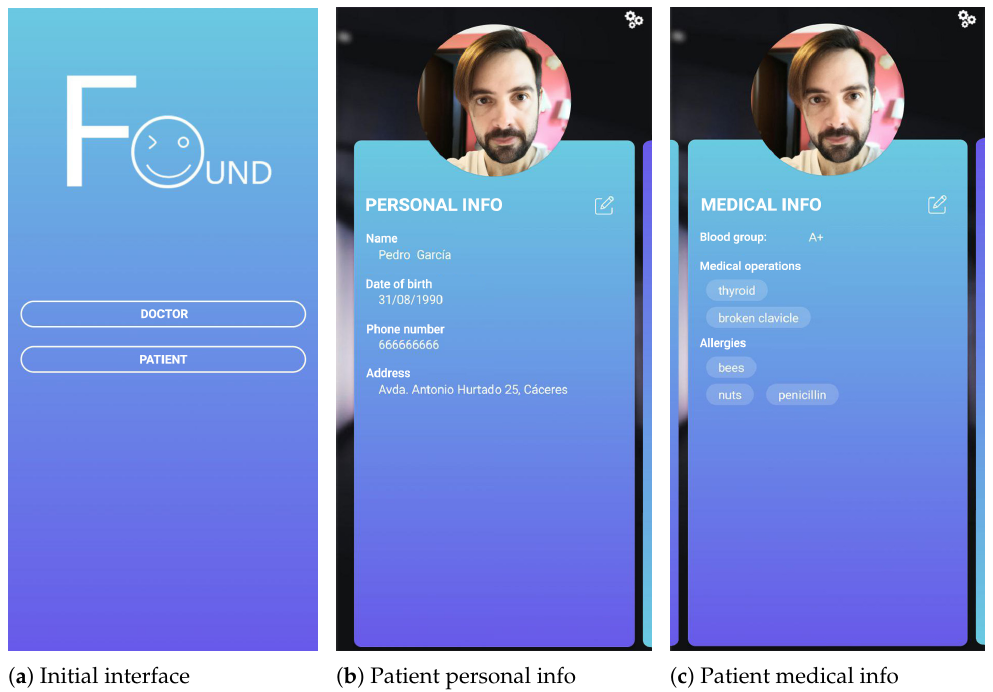
Figure 3. APP main